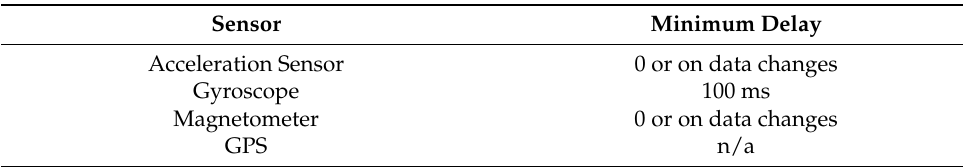
Table 2. Minimum data retrieval rate required per sensor.